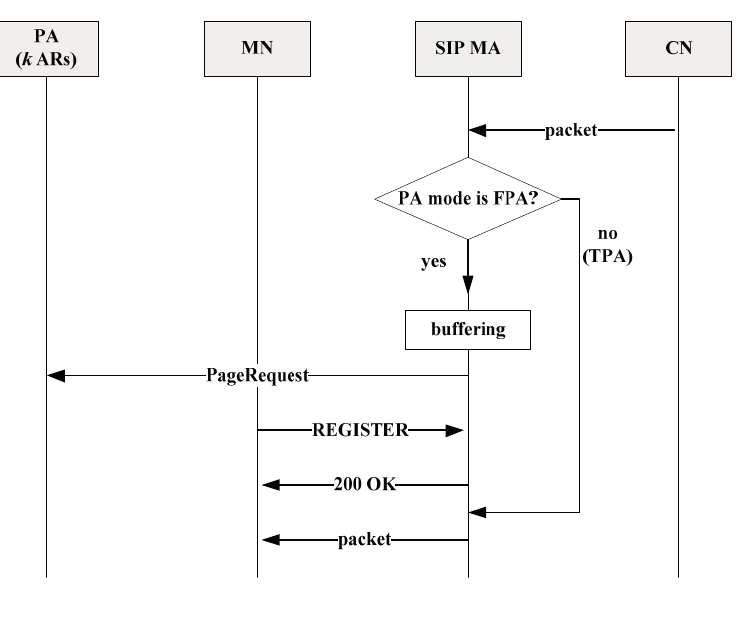
Figure 7. Packet delivery procedure.